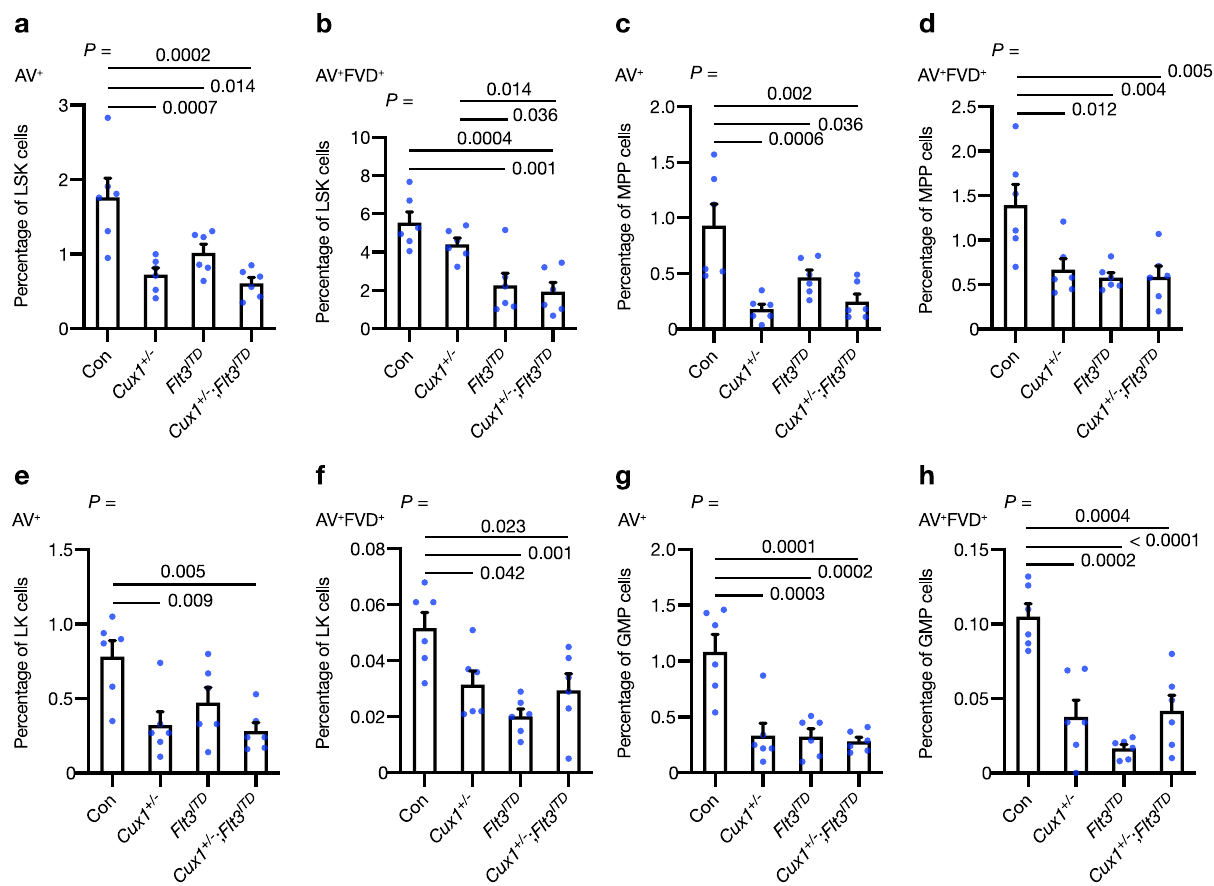
Fig. 5 Apoptosis defects in Cux1 + / − ; Flt3 ITD hematopoietic stem and progenitor cells. a , b Hematopoietic stem and progenitor cells were identi fi ed by fl ow cytometry and apoptosis within each compartment was determined by staining with Annexin-V (AV) and a fi xable viability dye (FVD). Percentage of early- (AV + ) ( a ) and late- (AV + FVD + ) ( b ) apoptotic cells in LSK compartments of mice from control Con, Cux1 + / − , Flt3 ITD and Cux1 + / − ; Flt3 ITD genotypes at 10-12 weeks of age ( n = 6 per group). c – h Percentage of AV + ( c , e , g ) and AV + FVD + ( d , f , h ) apoptotic cells in MPP ( c , d ), LK ( e , f ) and GMP ( g , h ) compartments of mice from the indicated genotypes at 10-12 weeks of age ( n = 6 per group). All plots show mean + s.e.m. Each circle represents one mouse. One-way ANOVA with Tukey ’ s test for multiple